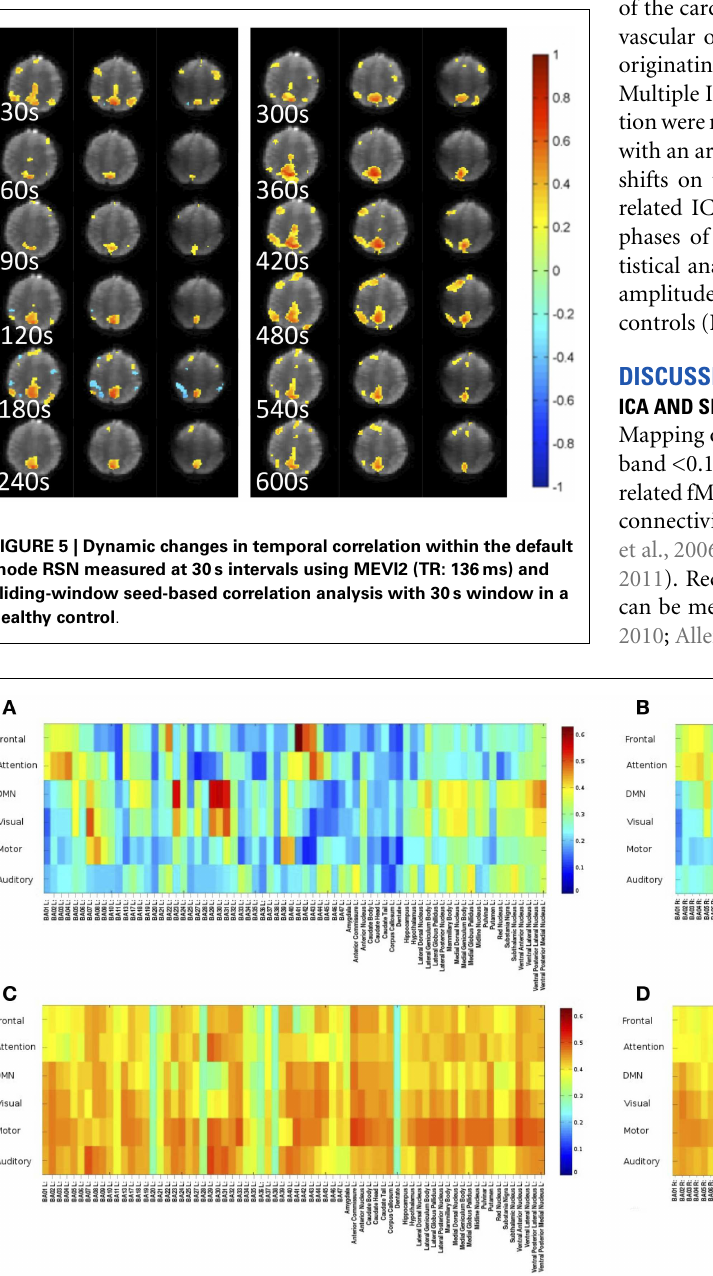
hemisphere meta-statistics means, (B) right hemisphere meta-statistics means, (C) left hemisphere meta-statistics standard deviations, and (D) right hemisphere meta-statistics standard